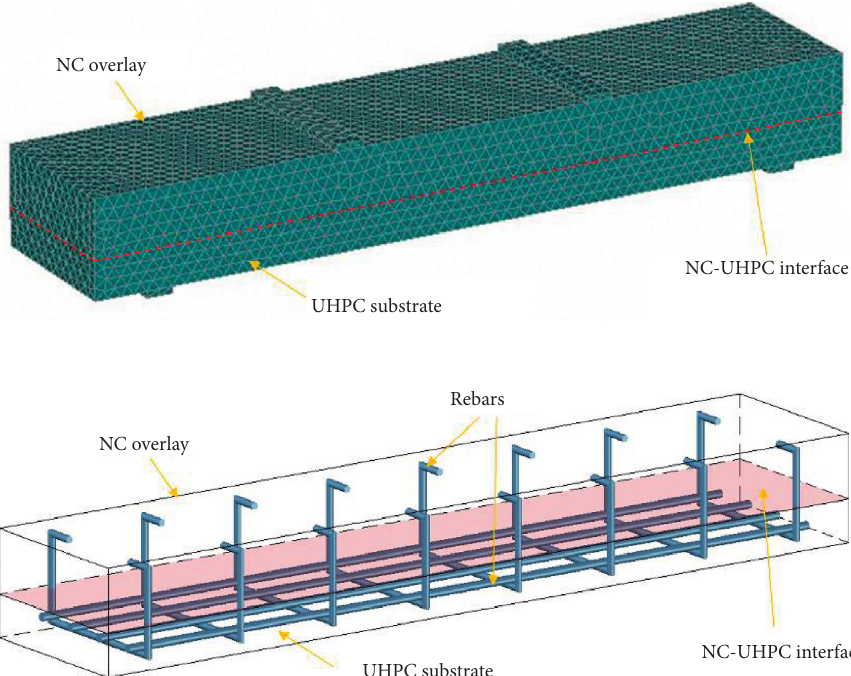
Figure 22: Summary of reinforcing layout and ATENA models for the NC-UHPC